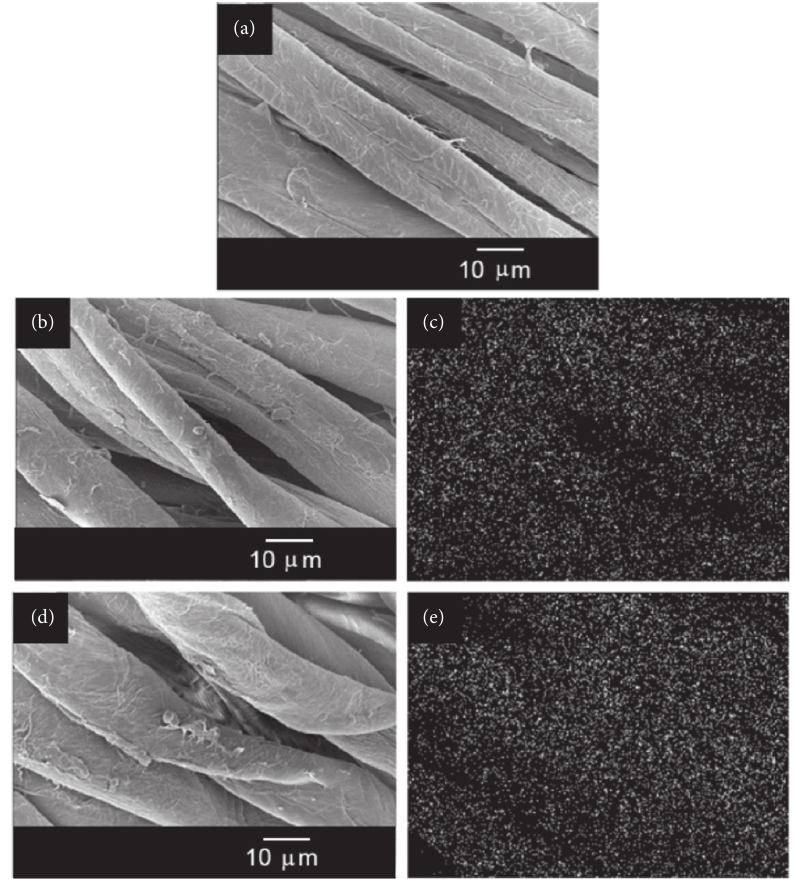
Figure 4: Scanning electron micrographs of cotton fabrics: (a) uncoated cotton, (b) Cot-10, and (c) EDX mapping of